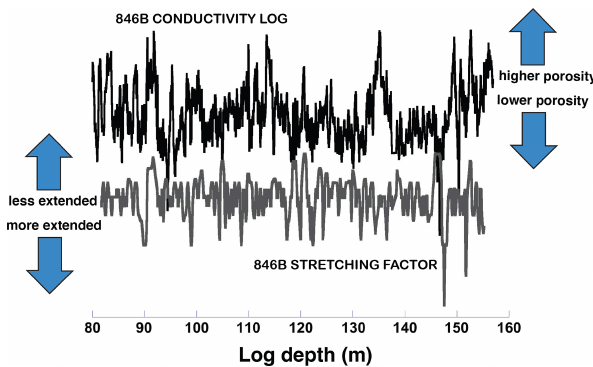
Figure 4. Coring distortion inferred from Match alignment of the Hole 846B GRAPE composite section to the borehole conductiv- ity log (conductivity data detrended and normalized) generated us- ing the “high-resolution” Match parameters emphasizing the clos- est possible mapping of core data to the downhole log. Note that core stretching generally moves positively with lower-conductivity and/or porosity (higher carbonate content).